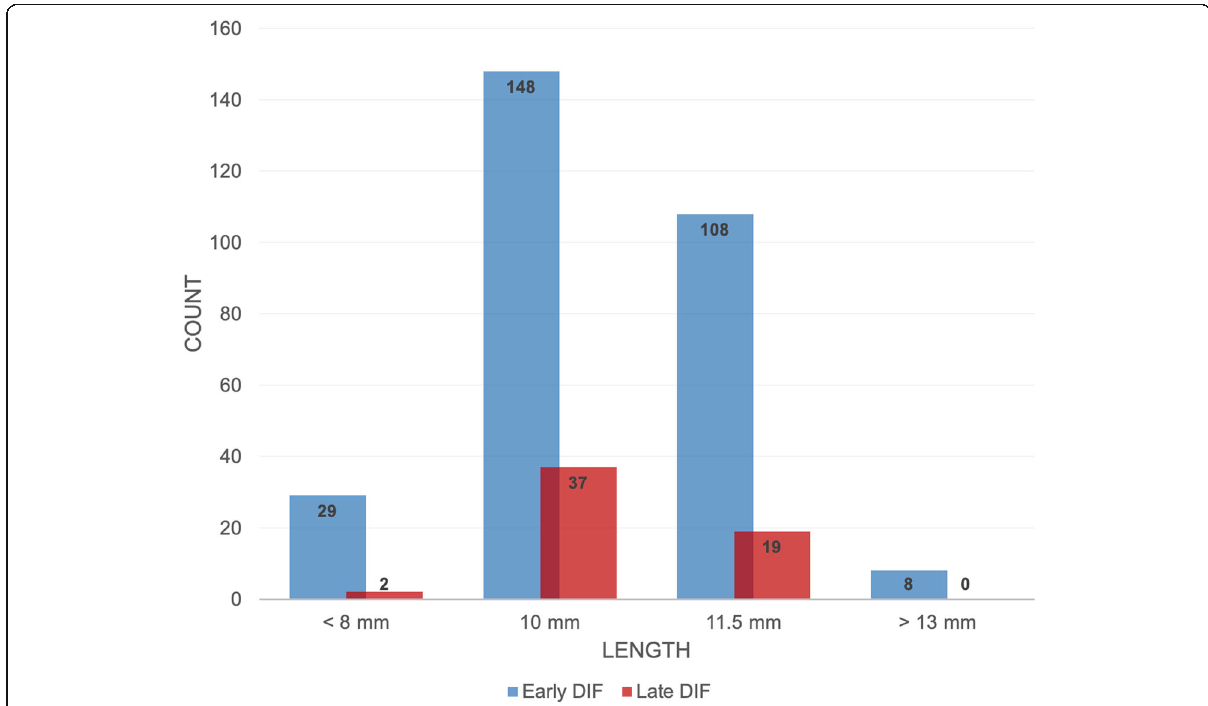
Fig. 3 Frequency of early and late dental implant failure among implants of different length. Early DIF was frequent in implants of 10 mm ( n = 134, 38.2%), whereas late dental implant failure showed high incidences in implants measuring 10 mm ( n = 51, 14.5%) and 11.5 mm ( n = 47, 13.4%) in